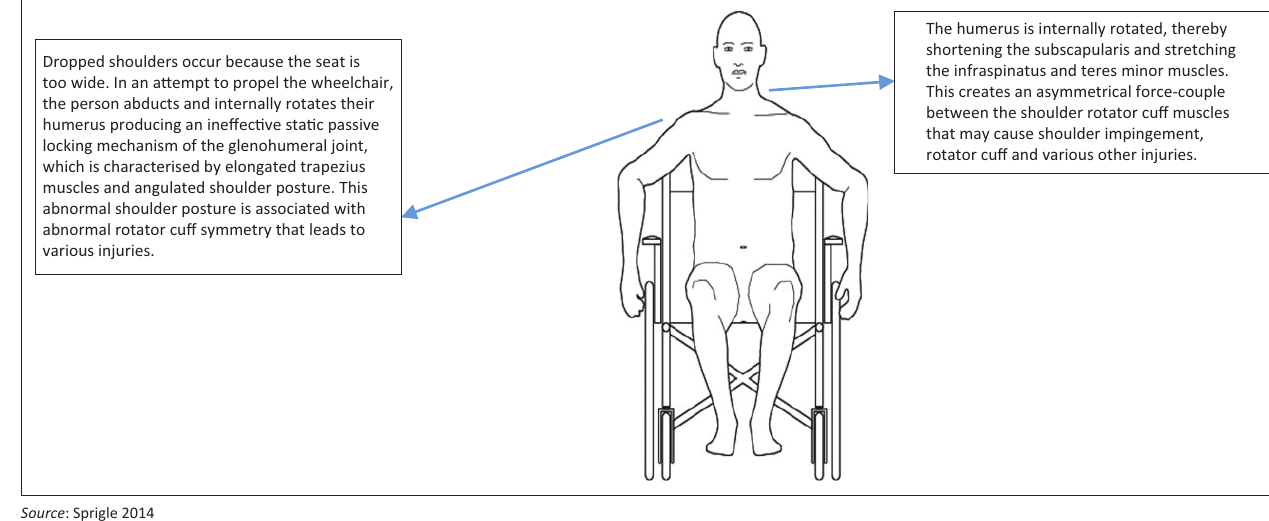
FIGURE 2: Frontal plane analysis identifying dropped